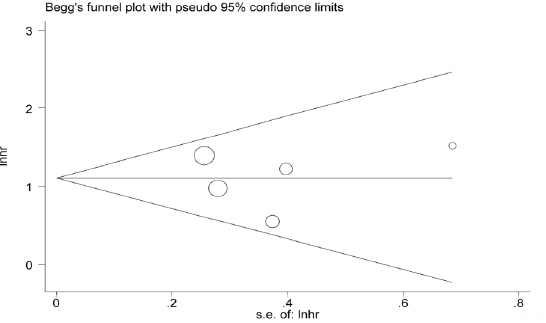
Fig 4. Begg's funnel plot to evaluate OS. Funnel plot showing symmetry indicative of no evidence of publication bias for